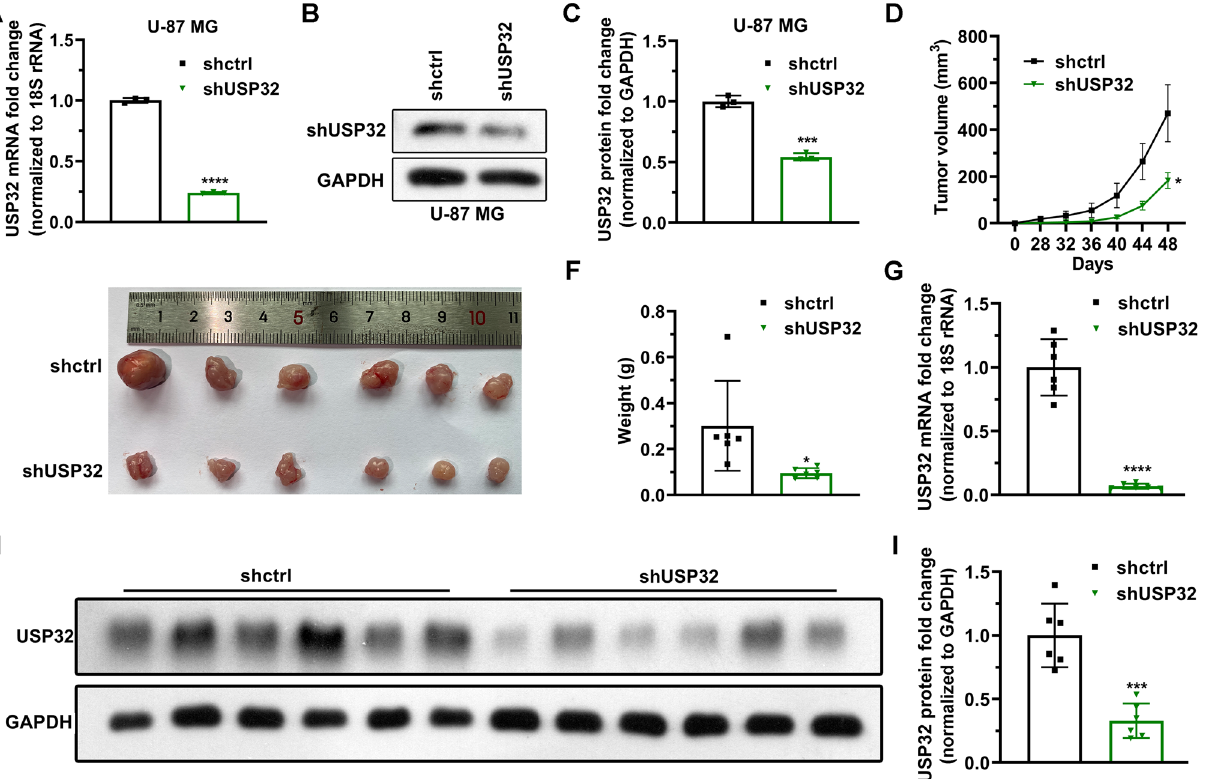
Figure 5. Knockdown of USP32 suppresses tumor growth in vivo. ( A , C ) Stably USP32-knockdown U-87 MG cell lines were successfully constructed, determined using RT-qPCR ( A ) and western blotting ( B , C ). Data are represented as mean ± SD of three technical replicates. ( D ) Tumor volume was tracked every 4 days by calculating using the formula: volume = long diameter × short diameter 2 /2. Data are represented as mean ± SD of six mice. ( E ) The image of tumors. The mice were euthanized using isoflurane at day 48 and tumors were dissected off. ( F ) USP32 knockdown reduced the weight of tumors. Data are represented as mean ± SD of six mice. ( G ) RT-qPCR analysis degerming the mRNA level of USP32 in tumor tissues. Data are represented as mean ± SD of six mice. ( H ) Western blotting. ( I ) Statistical quantification of ( H ). Unpaired Student’s t test: vs shctrl, * p < 0.05, *** p < 0.001, **** p <